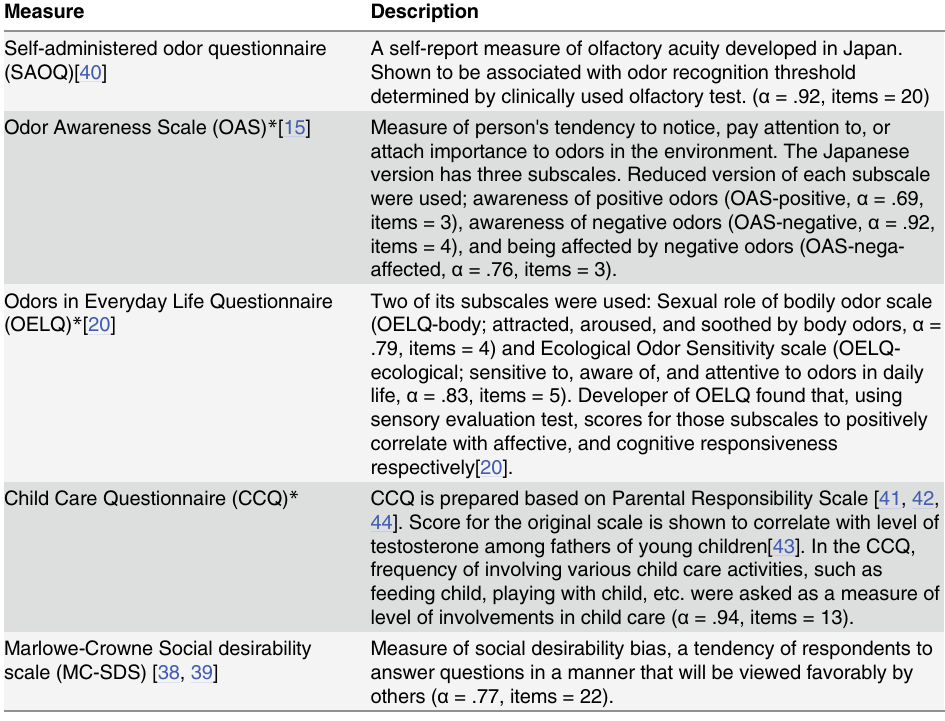
Table 2. Measures used to examine concurrent validity of the Child Odor in Parenting scale